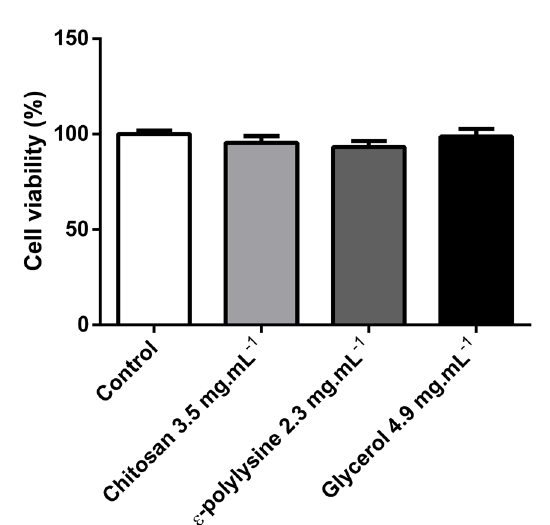
FIGURE 6 - Cell viability of fibroblasts 3T6-Swiss Albino treated with chitosan, ɛ -Polylysine and glycerol (MTT